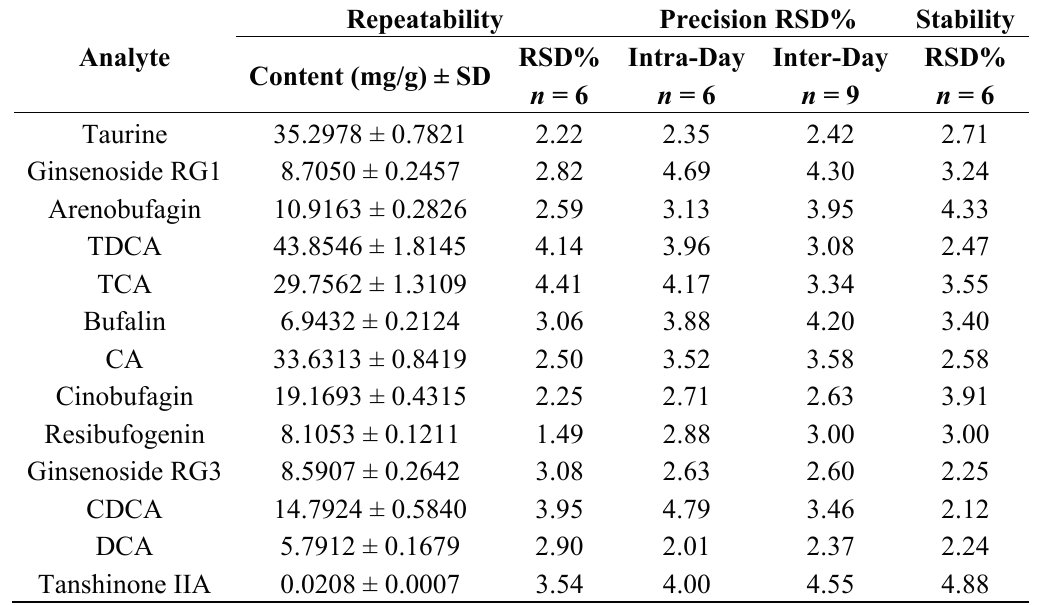
Table 3. Precision, repeatability, stability of 13 detected components of STP.